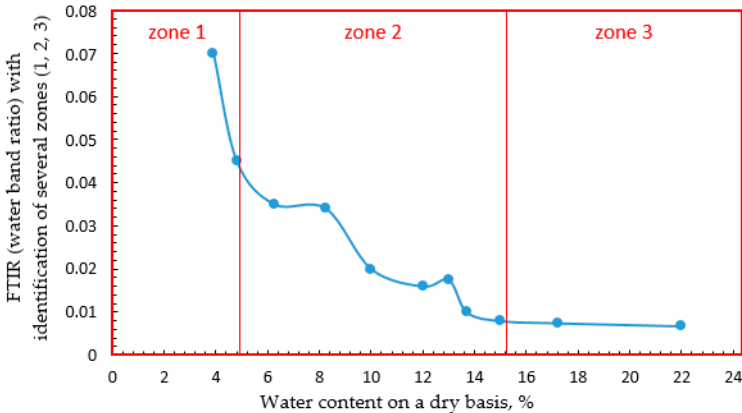
Figure 4. FTIR (Fourier transform infrared spectroscopy) water band ratio changes as a function of hydration. Three zones can be observed which correspond to: 1, high energy bonding of water to the protein; 2, steady medium rate of hydrogen bonding of water to the protein network; and 3, slow hydration rate of poly-molecular layer water to the modified network [54].